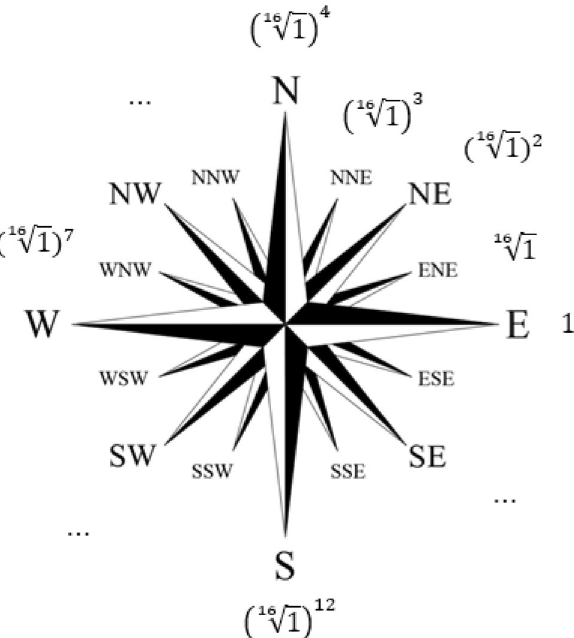
Figure 2. 16-element compass rose (Image was generated in Paint 22H2 https:// apps. micro soft. com/ store/ detail/ paint/ 9PCFS 5B6T7 2H? hl= ru- ru& gl=